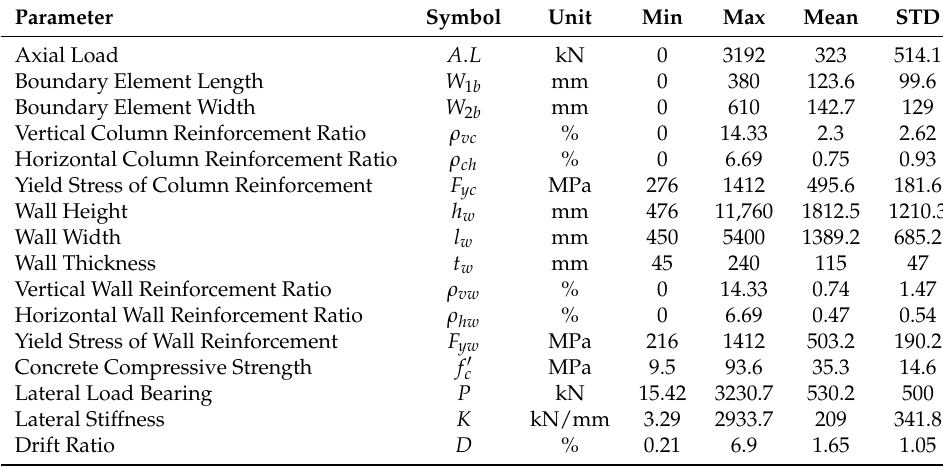
Table 2. Statistics of the parameters in RCSW